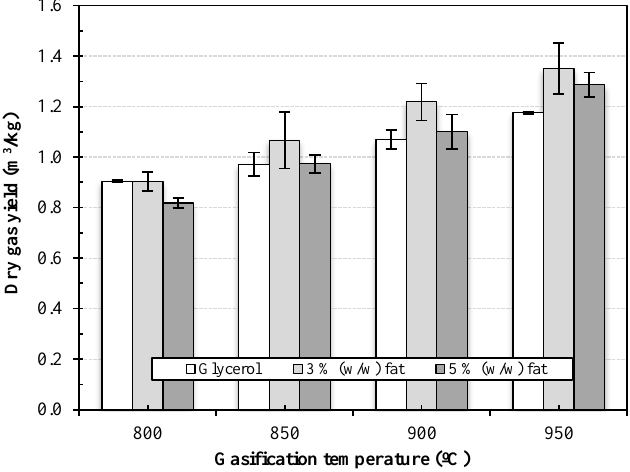
Figure 8. E ff ect of the addition of fat on carbon and hydrogen conversion e ffi ciencies. Energies 2020 , 13 , x FOR PEER REVIEW Figure 8. Effect of the addition of fat on carbon and hydrogen conversion efficiencies.